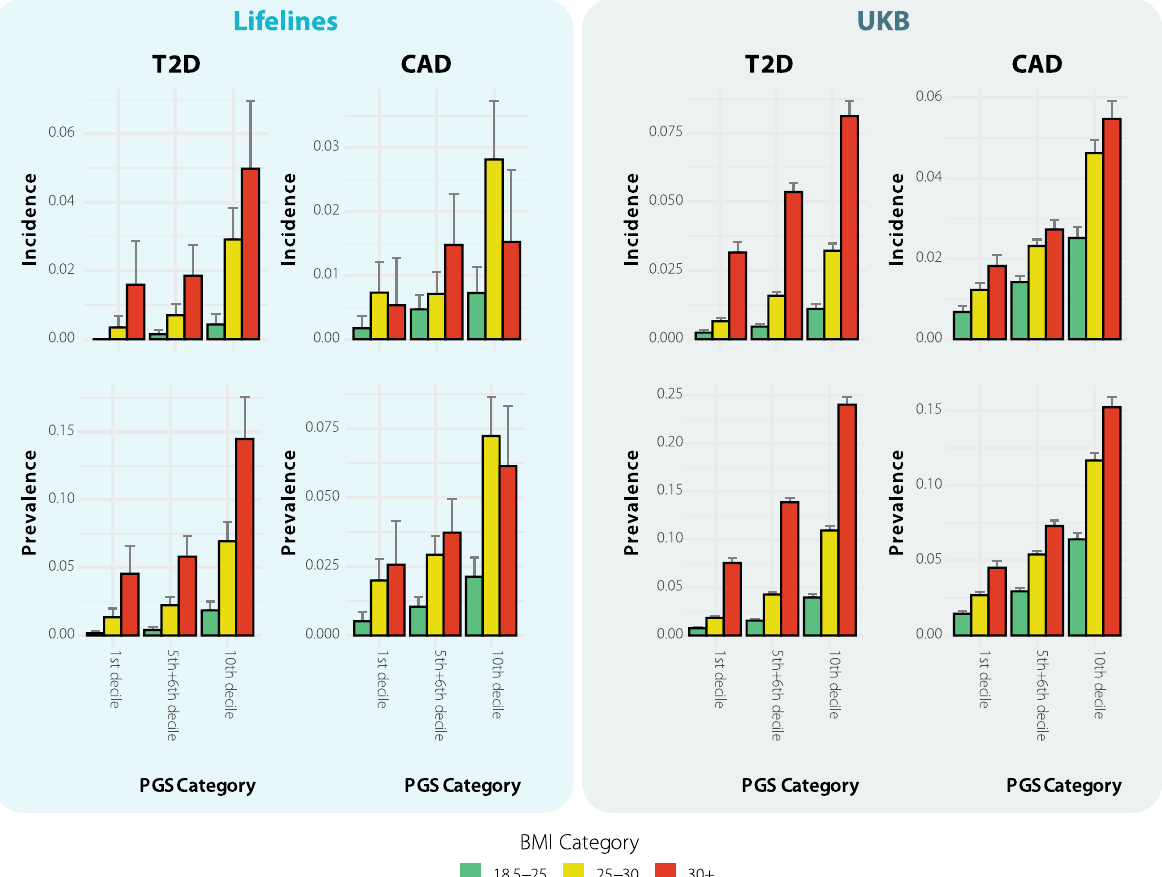
Figure 5. Comparison of diabetes incidence and prevalence in individuals with different genetic risk profiles and different BMI categories. Individuals with a high genetic risk profile benefit more from having a lower BMI in terms of absolute risk reduction, under the assumption that BMI is causal. Bars indicate 95% confidence